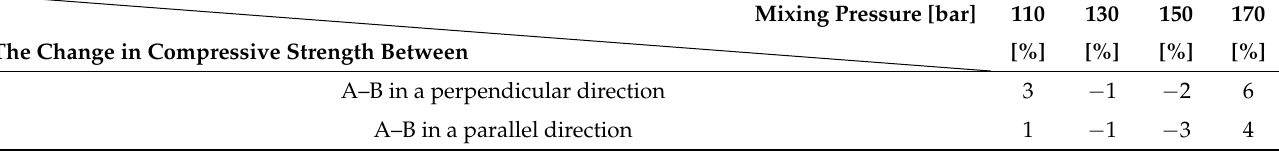
Table 5. Variation in compressive strength between foam samples taken from different locations.